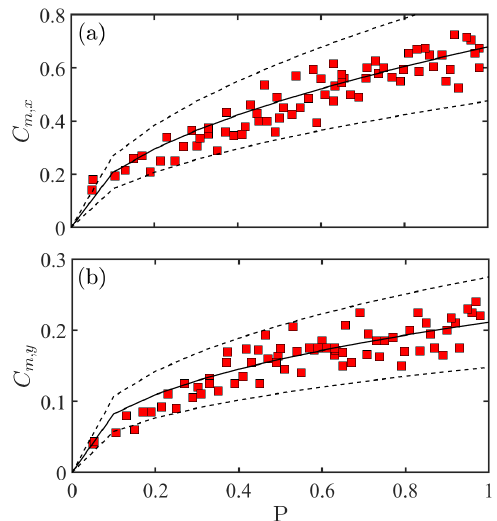
Figure 11. Variation of ( a ) C m , x and ( b ) C m , y with P. The solid line and the dashed lines denote the fitting curve and the ± 30% derivation range, respectively.